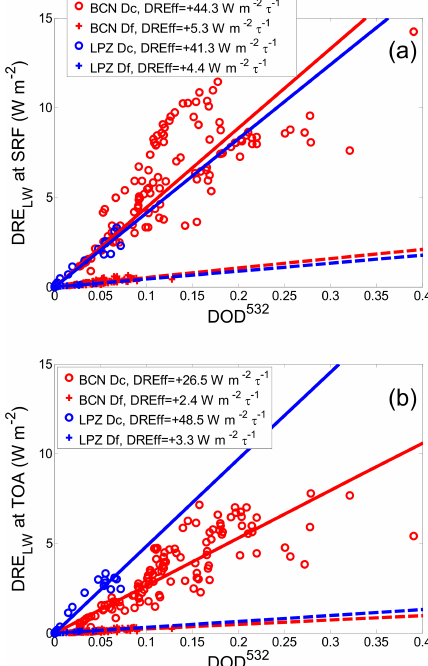
Figure 11. Dust long-wave direct radiative effect (DRE LW ) at (a) SRF and (b) TOA as a function of DOD 532 , as shown sepa- rately for Dc (circles) and Df (crosses) at BCN (23–30 June) and LPZ (29–30 June). Corresponding DREff values (slope of the lin- ear fitting of DRE LW vs. DOD 532 ) are included in the legend (solid and dashed lines, respectively, for Dc and Df